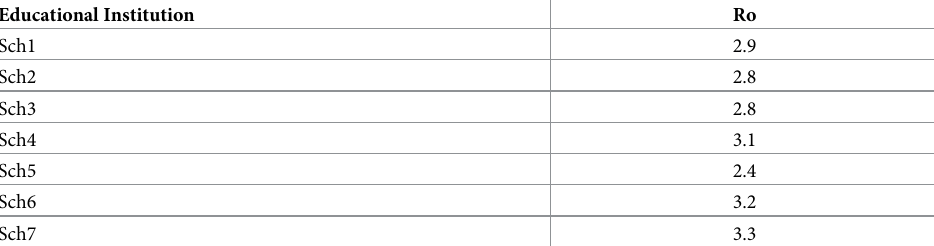
Table 3. R 0 calculated for each school network. The value of R 0 was based on the secondary cases. This operation accounted for the infected agents, contacts infected, and agent out-degree. Additionally, the model included the inter- val of time when the infected curve was growing to avoid a subestimation due to a low number of susceptible agents. The registered value is an average over the infected nodes and the repetitions.